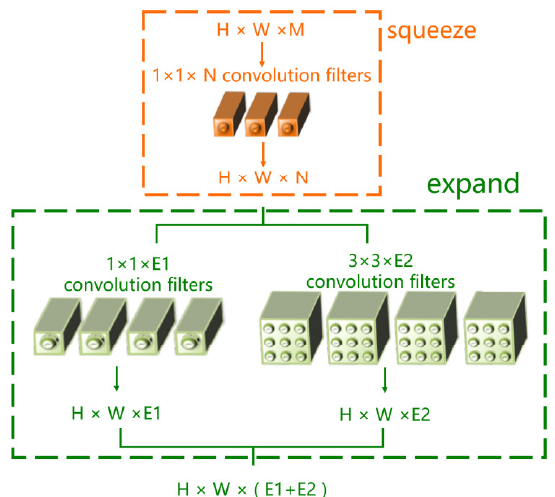
Figure 8. Fire module structure. The fire module is defined as fire (M, N, E1, and E2), where M and N represent the number of input and output channels, respectively, of the squeeze layer. E1 and E2 represent the number of output channels of expand layer 1 × 1 and expand layer 3 × 3, respectively.